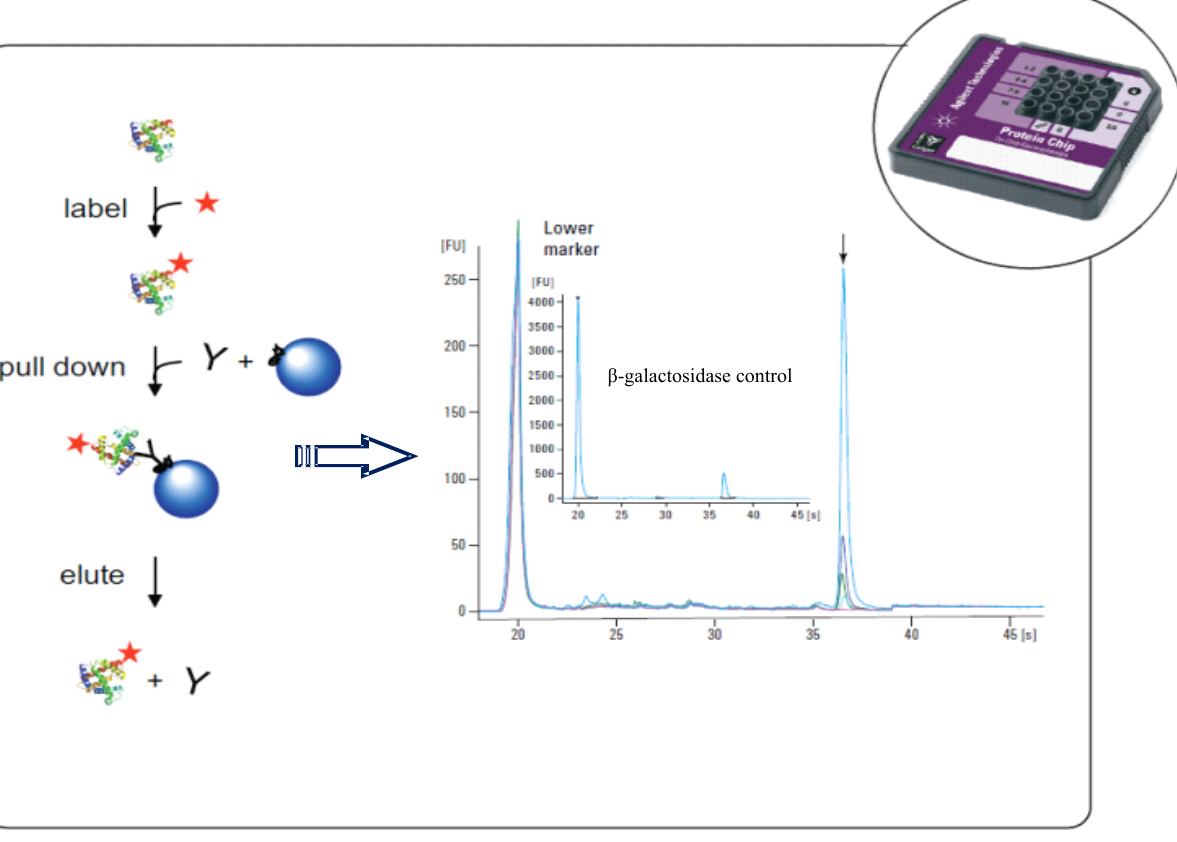
Figure 6. Immunoprecipitation combined with microcapillary electrophoresis. Adapted from